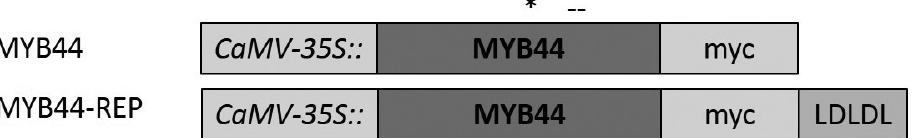
Figure 3. Stable expression of MYB44-REP in transgenic Arabidopsis